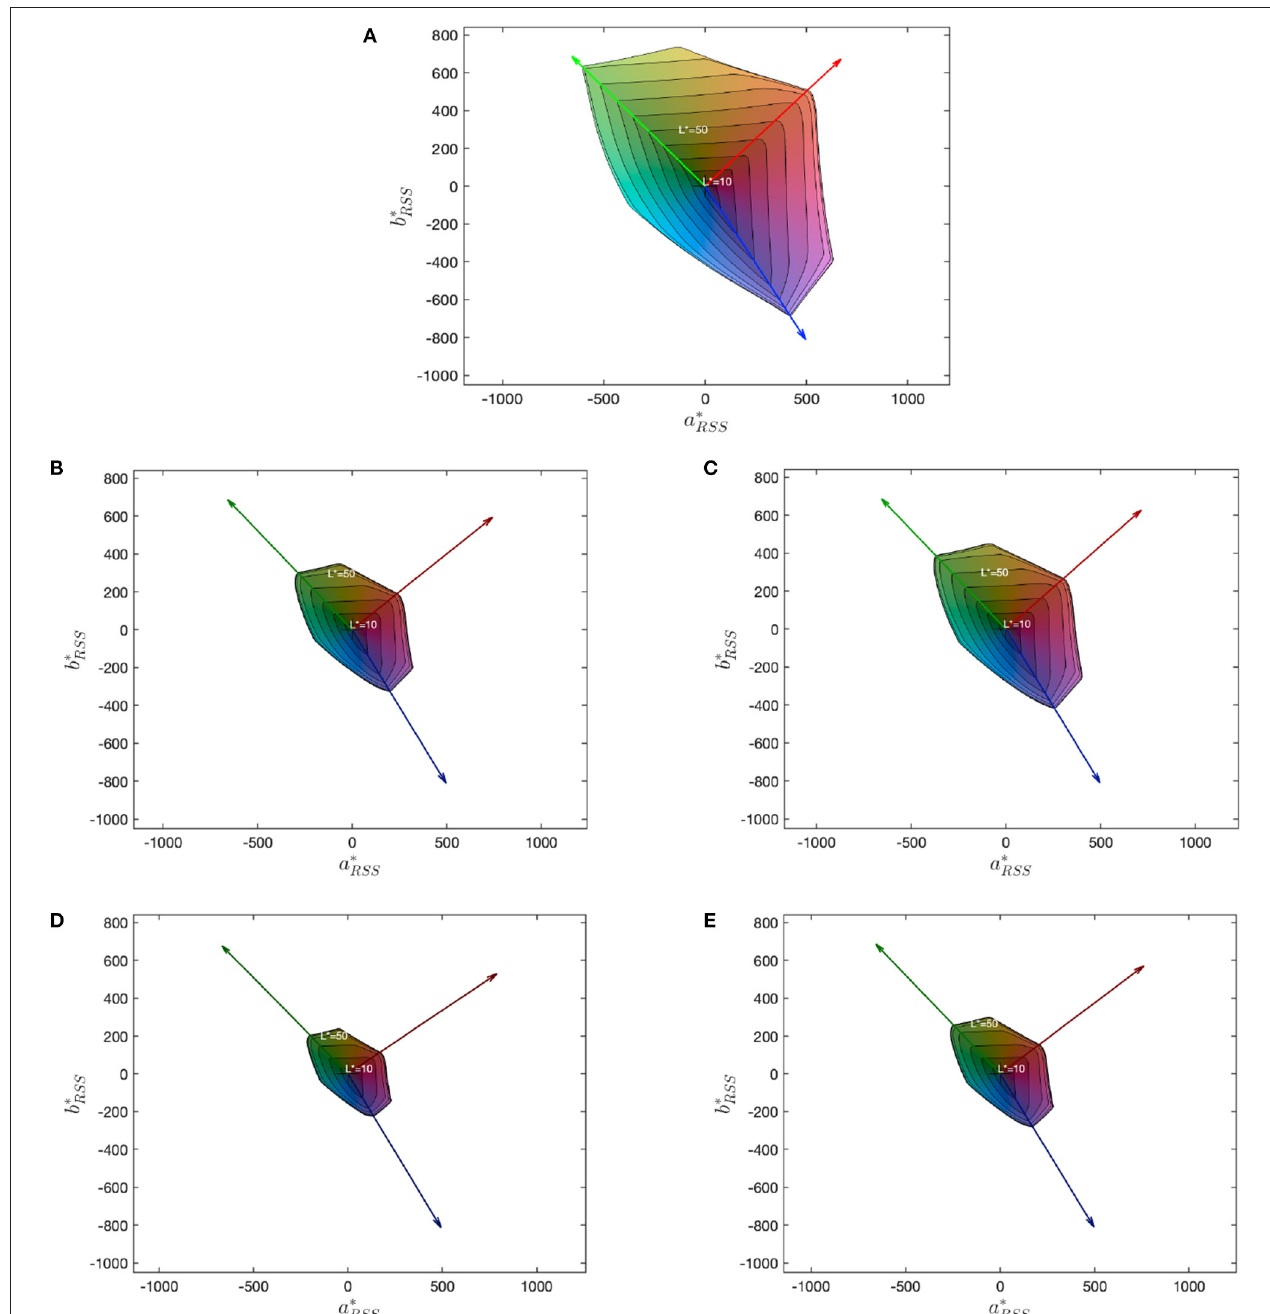
FIGURE 1 | Gamut rings (Smith et al., 2020) for each gamut ( A–E for gamut #1–5, respectively). The area of the outermost boundary in the gamut rings correspond to the CGV. The coordinates are on the CIELAB a ∗ − b ∗ plane, where the subscript RSS means the root sum square of the equivalent a ∗ / b ∗ values (Masaoka et al., 2020). The differences between consecutive equal-lightness contours depends on both the WLO/CLO ratio and the white channel activation position.